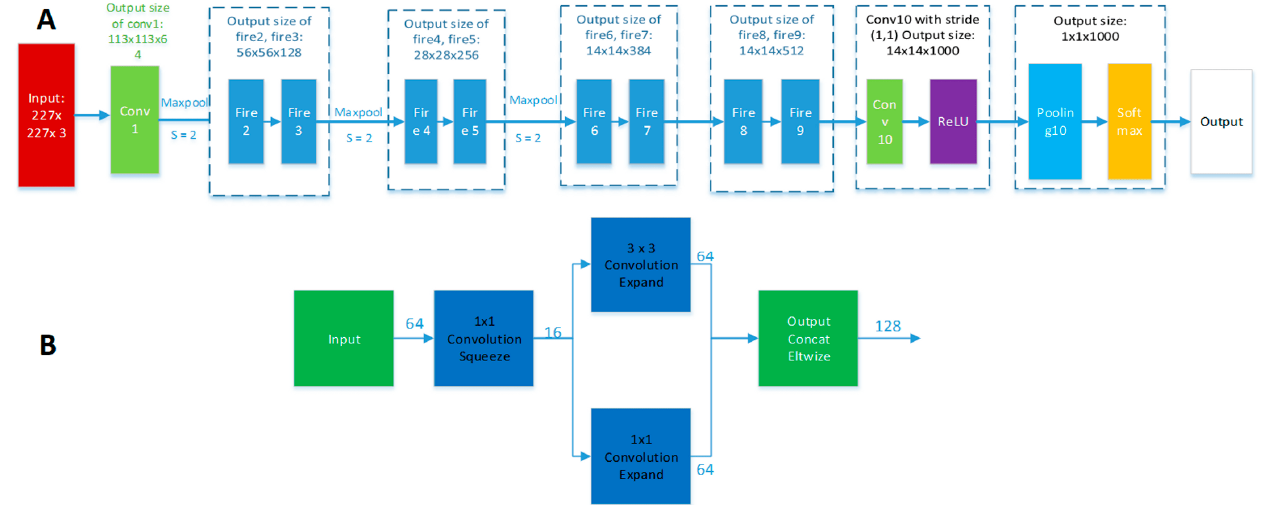
Figure 7. SqueezeNet architecture. ( A ) Full view and ( B ) fire unit with squeeze and expand layers.